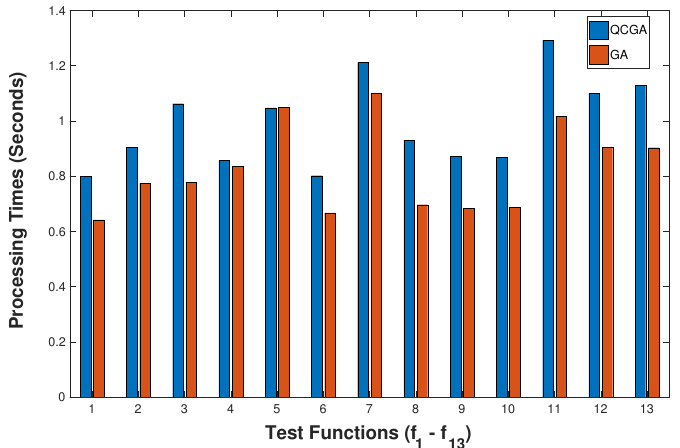
Figure 10. Processing times for the QCGA and GA codes using f 1 – f 13 test